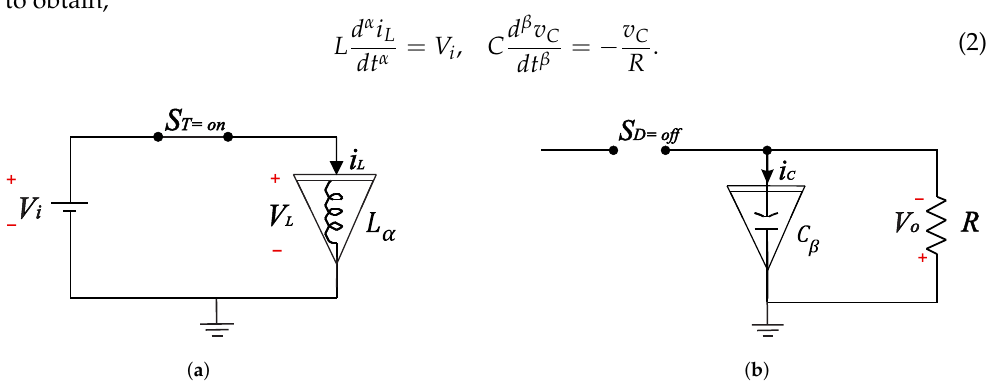
Figure 2. Equivalent circuits of the Buck-Boost converter in State 1 with S T = on and S D = off. ( a ) Equivalent circuit of the Buck-Boost converter in State 1 and S T = ON. ( b ) Equivalent circuit of the Buck-Boost converter in State 1 and S D = OFF.